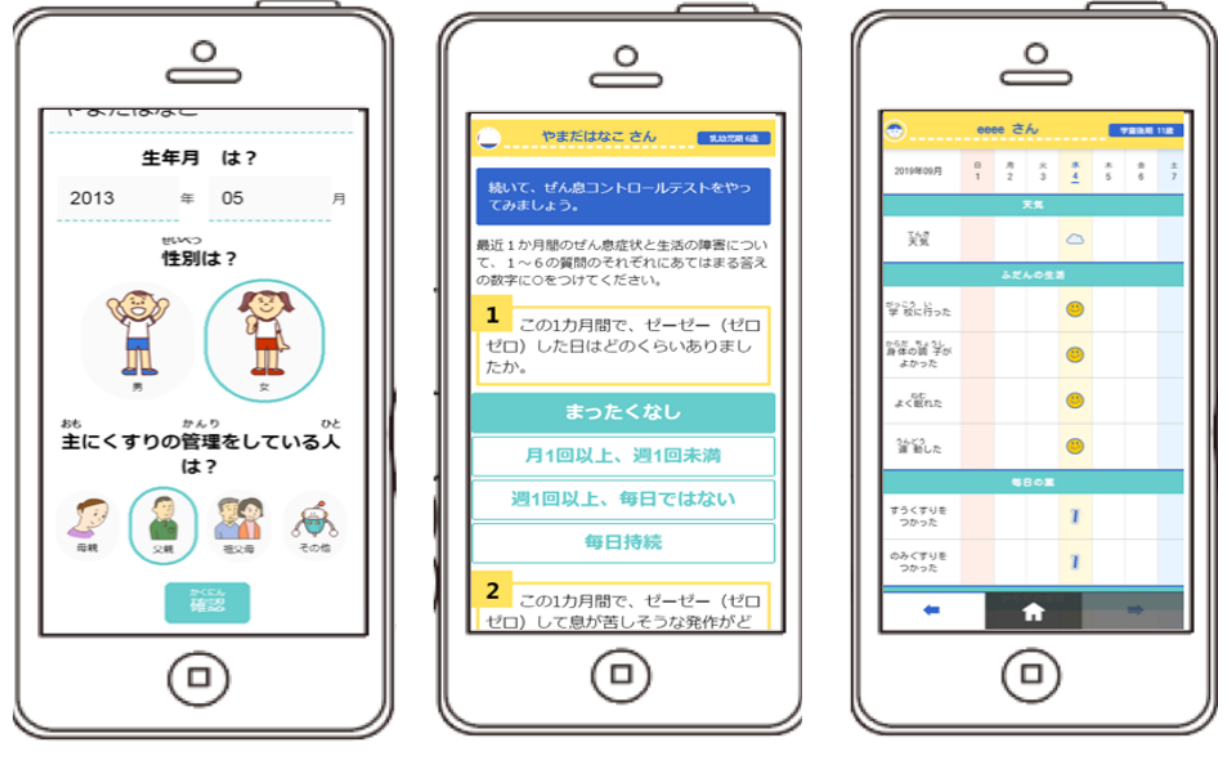
Figure 1. Examples of a mobile asthma app for children and their caregivers: screens commonly used for children <12 years old; setting screen (left), childhood asthma control test (middle), and self-monitoring